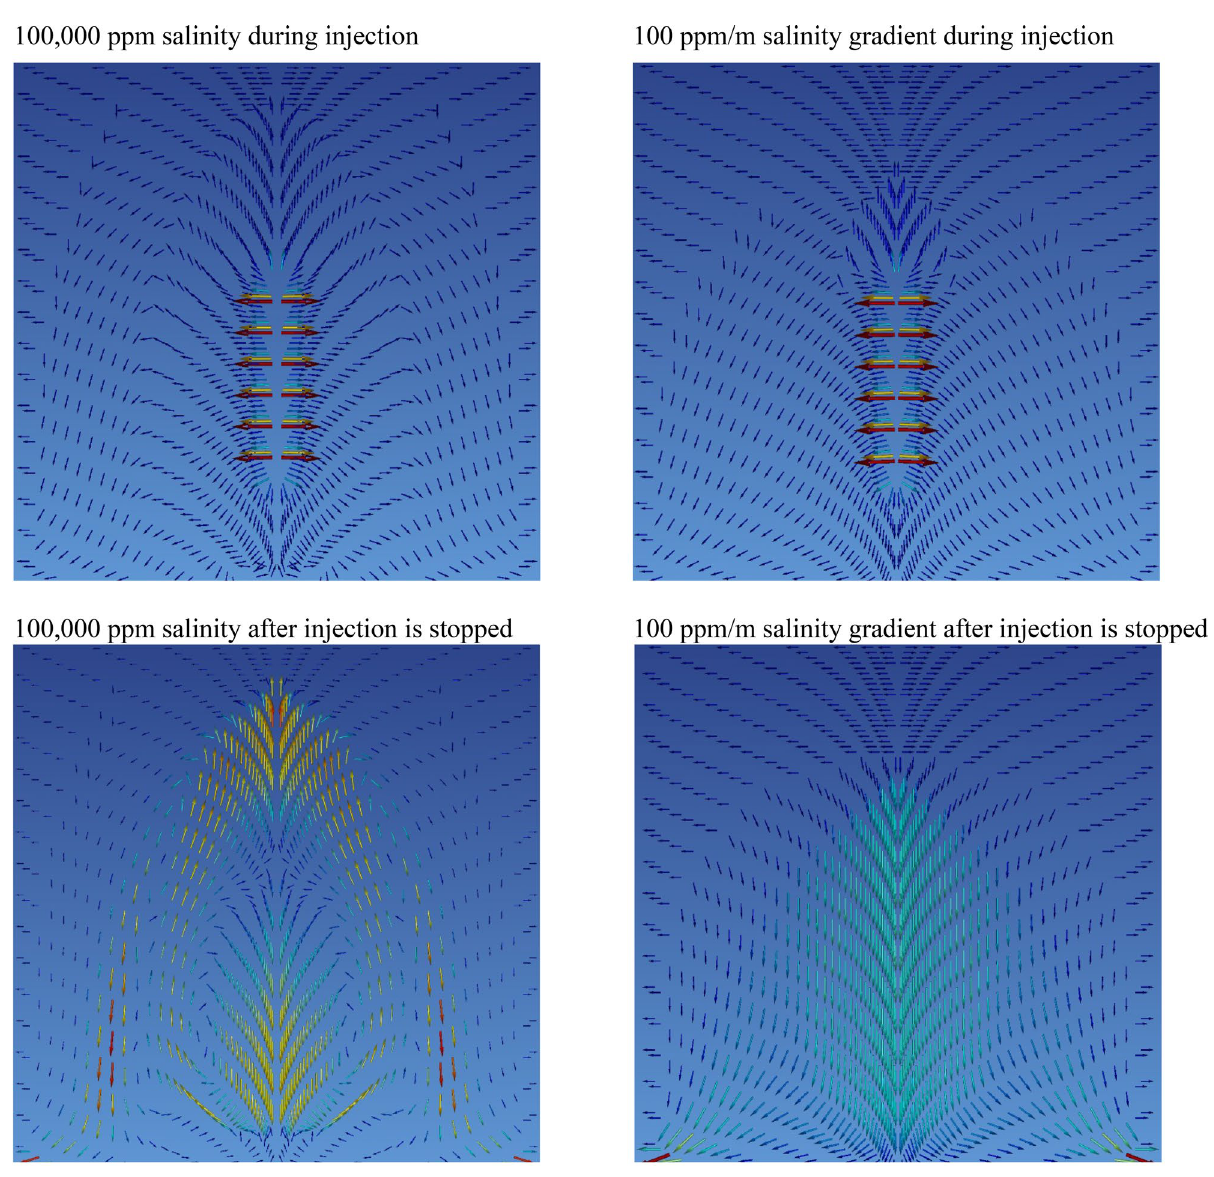
Figure 6. Comparison of the dissolved CO 2 flow paths during the final stages of injection and after the injection has stopped. The left plots represent the flow paths in a system having a constant initial salinity of 100,000 ppm. The right plots represent the flow paths in a system with an initial salinity gradient of 100 ppm/m. Carbonated water was injected for 50 years for the constant initial salinity of 100,000 ppm, and for 100 years for the initial salinity gradient of 100 ppm/m. The non-blue colors highlight the higher flow rate zones, and the arrows indicate the flow